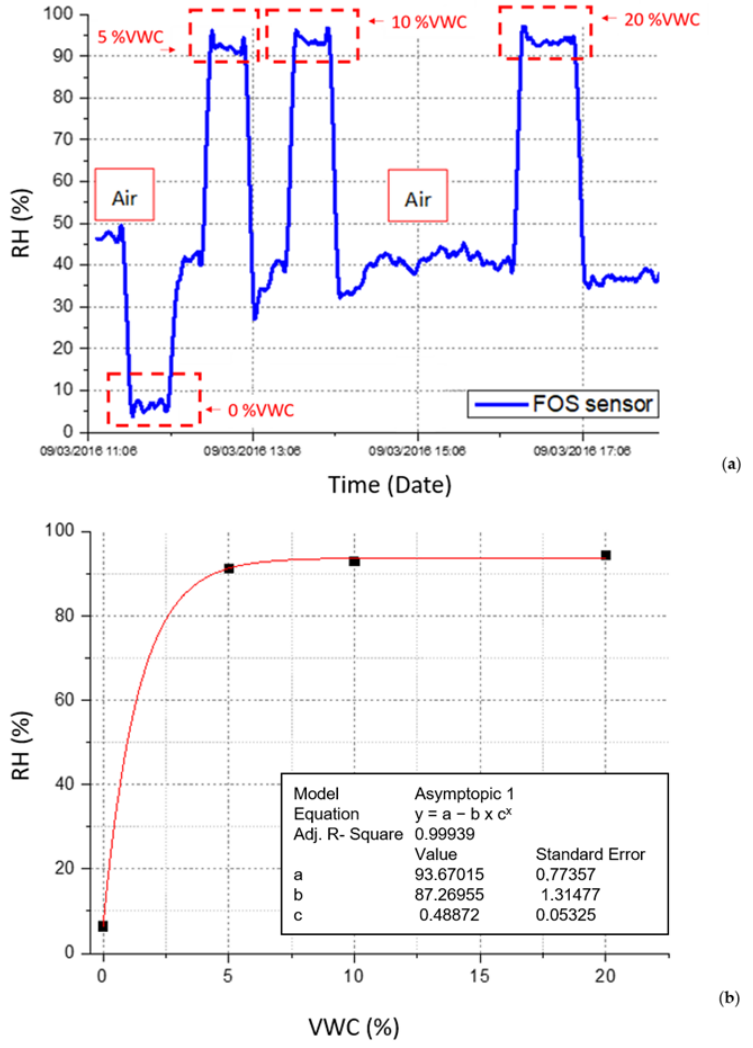
Figure 2. ( a ) FBG thermo-hygrometer response to incremental VWC values; ( b ) RH versus VWC calibration curve (from Ref. [53]).